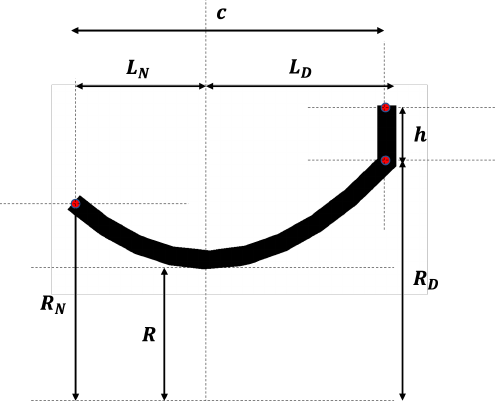
Figure 5. Geometric features of a wind lens profile.